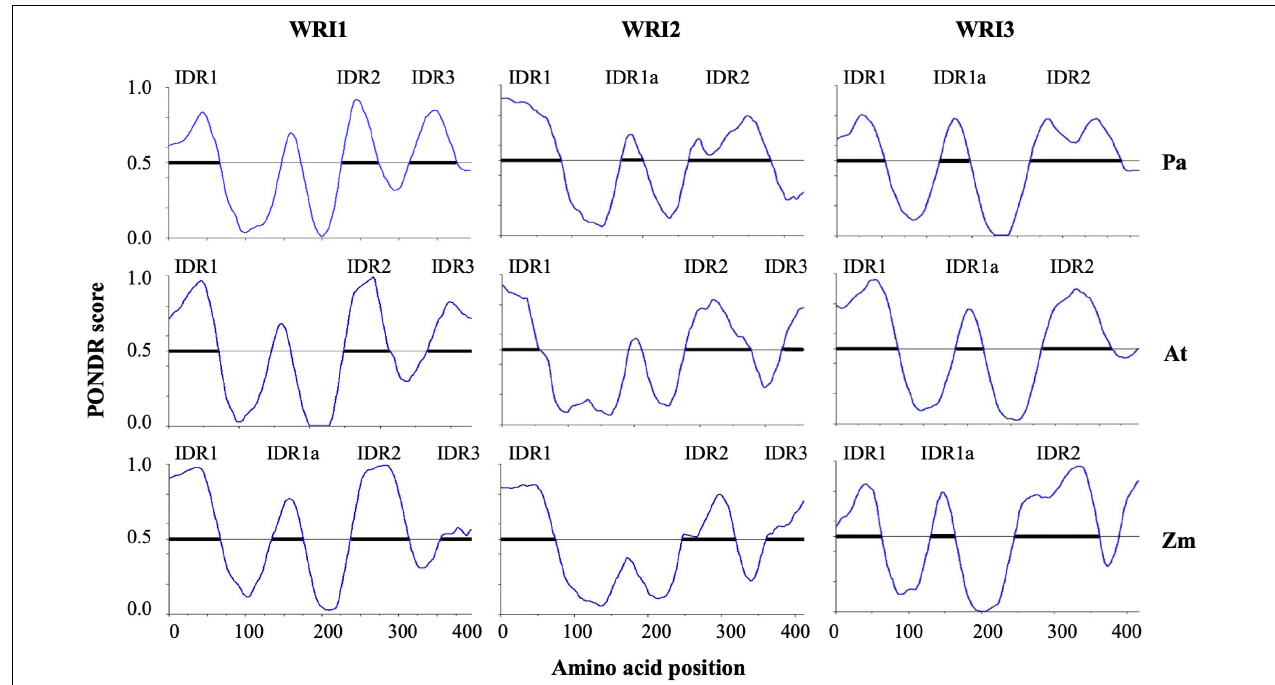
FIGURE 3 | Graphical representation of the predicted IDRs in the WRI homologs. The predicted IDRs in all the WRI homologs are graphically plotted with the amino acid position on the x -axis and the PONDR score on the y -axis. Regions showing PONDR score > 0.5 are considered as IDRs.